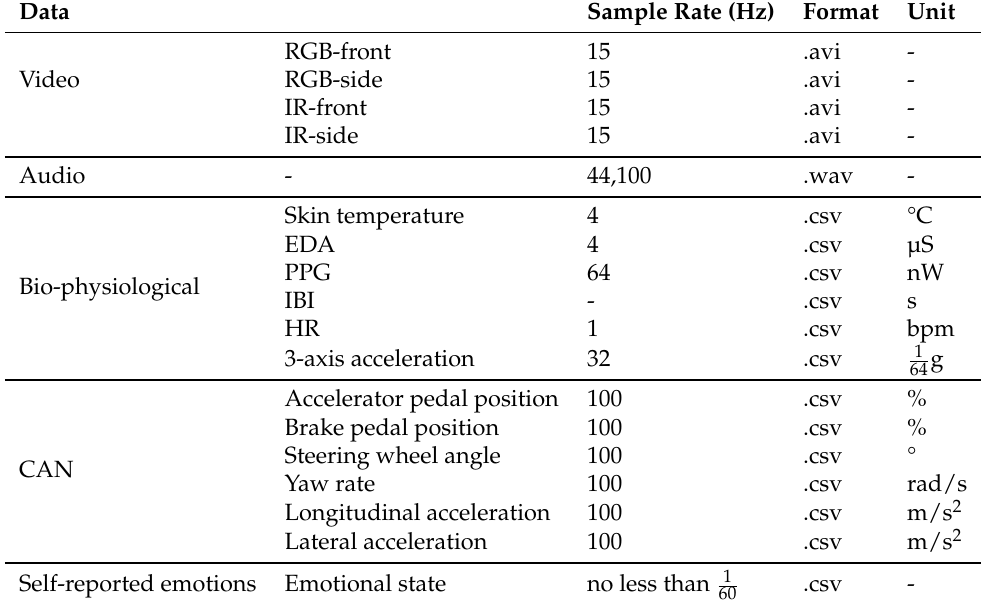
Table 1. Details of data collected by experiment.